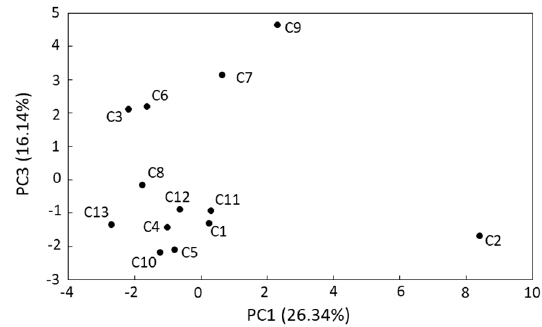
Figure 4. Principal component analysis biplot distribution of compost microbial communities on the base of community levels of physiological profiles assessed on Biolog® EcoPlate™ C-substrates, along the axes of principal component 1 (PC1) and 3 (PC3) describing, respectively, 26.34 and 16.14% of total data variability.